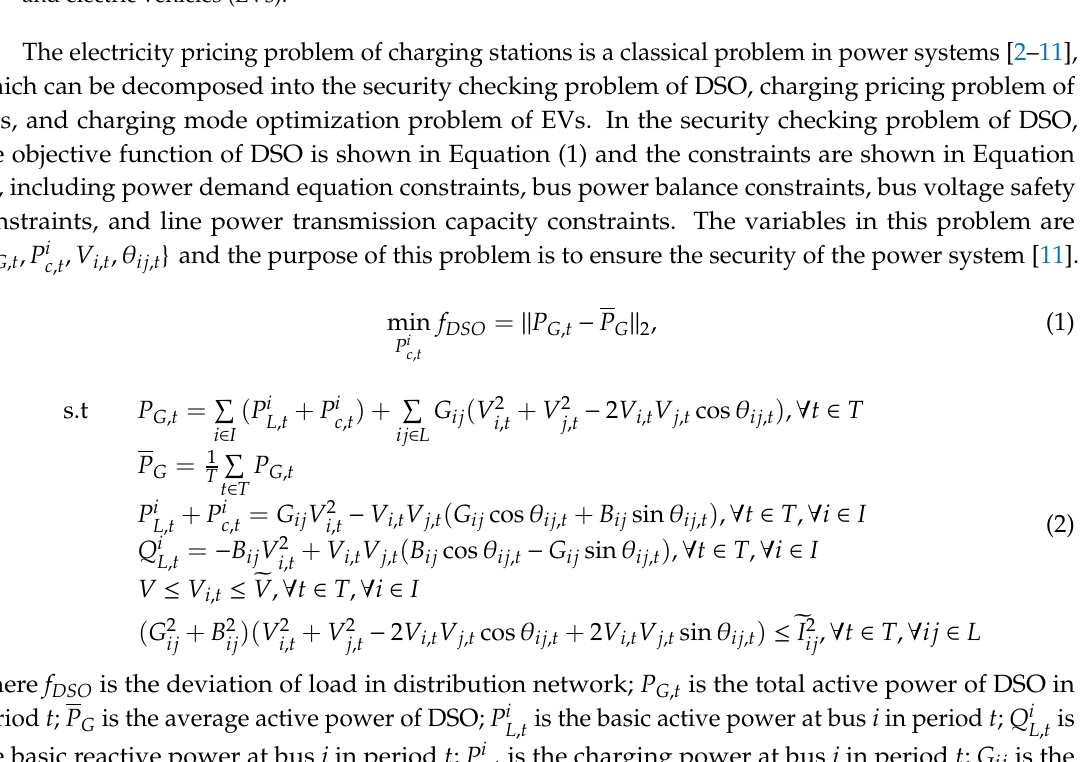
Figure 1. The relationship among distribution network operators (DSO), charging stations (CSs), and electric vehicles (EVs).